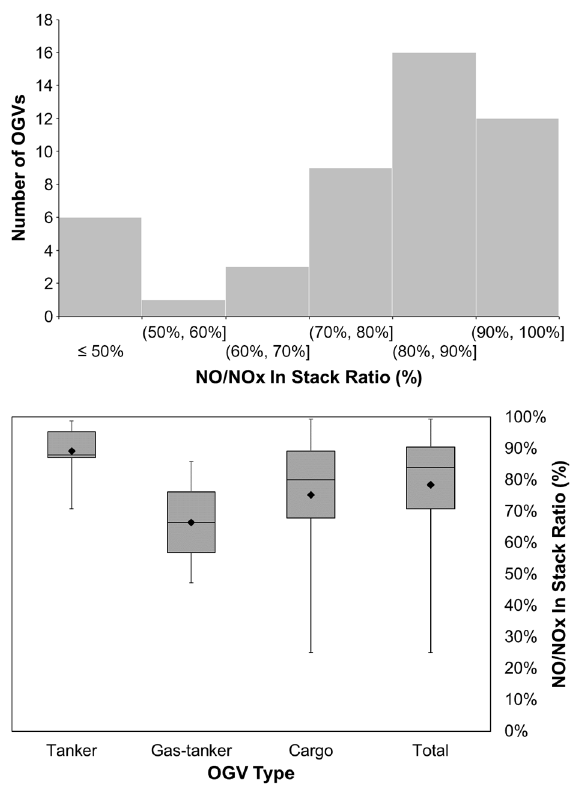
Figure 4. Upper: Histogram of the NO/NO x ratios calculated based on NO/CO 2 and NO x /CO 2 ratios. Lower: Comparison of NO/NO x ISR values between different OGV types.